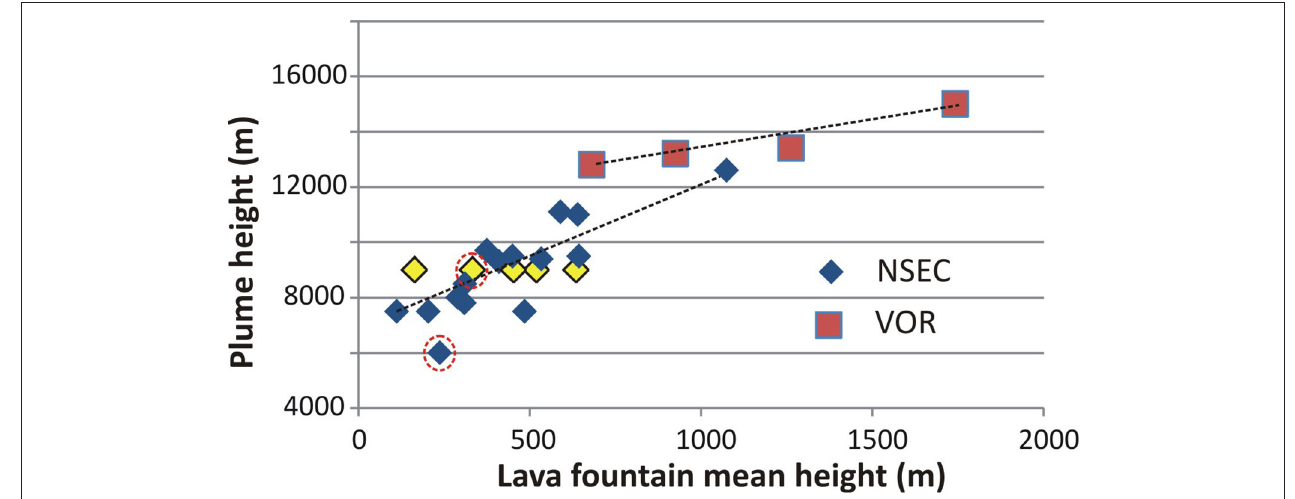
FIGURE 4 | Fountain average height H F vs. plume height H P . For the NSEC lava fountains, the H P values are taken from Scollo et al. (2014) for 19 lava fountains (from 10 April 2011 to 27 April 2013) with the criterion detailed in the text. To this database we added the measurements, highlighted by the red circles, coming from Calvari et al. (2011) for the event of 12 January 2011, and from Guerrieri et al. (2015) for the event of 23 October 2011. The four H P values of the VOR December 2015 events (red squares) are taken from Vulpiani et al. (2016). The five yellow diamonds show data taken from ECV, with the 9km a.s.l. limit.